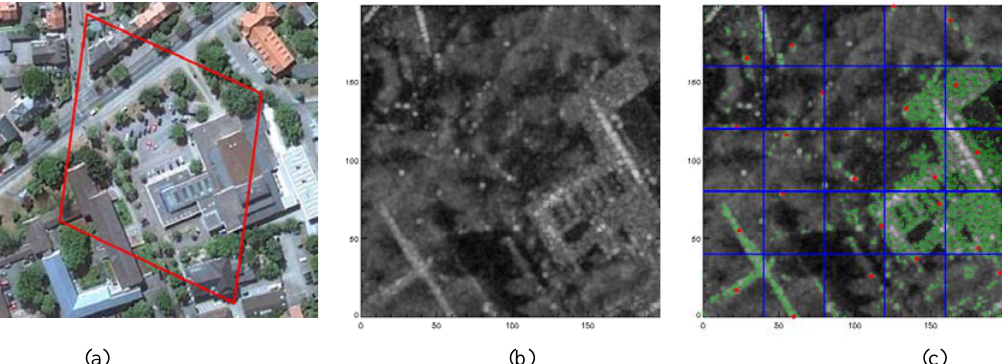
Figure 1: Identification of homogenous patches. (a) is a Google Earth image of a small part of Lueneburg in Germany, the region of interest is enclosed in red. (b) is the mean amplitude image of the region of interest. (c) shows the division of the region into blocks by the blue lines, wherein, the points in green represent the homogenous pixels and the points in red represent the reference